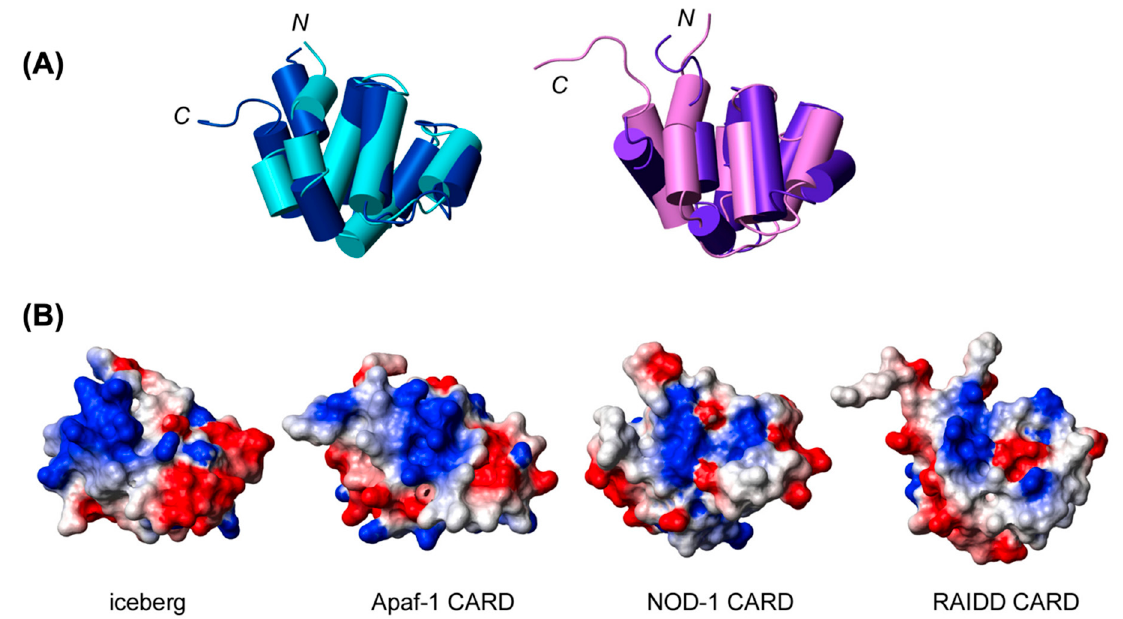
Figure 5. Structure comparison of caspase-activation and recruitment domains (CARDs) from different origins. ( A ) Superposition of Apaf-1-CARD (dark blue) [195] and iceberg (light blue) [199]. Superposition of RAIDD-CARD (pink) [200] and NOD-1-CARD (purple) [201]. Helix 1 (cylinder) in RAIDD-CARD, although not fragmented, is substantially bent and is shown as two cylinders; ( B ) electrostatic surface representation of CARDs in the same orientation as displayed in A. This figure is adapted from figure S4 of [183].